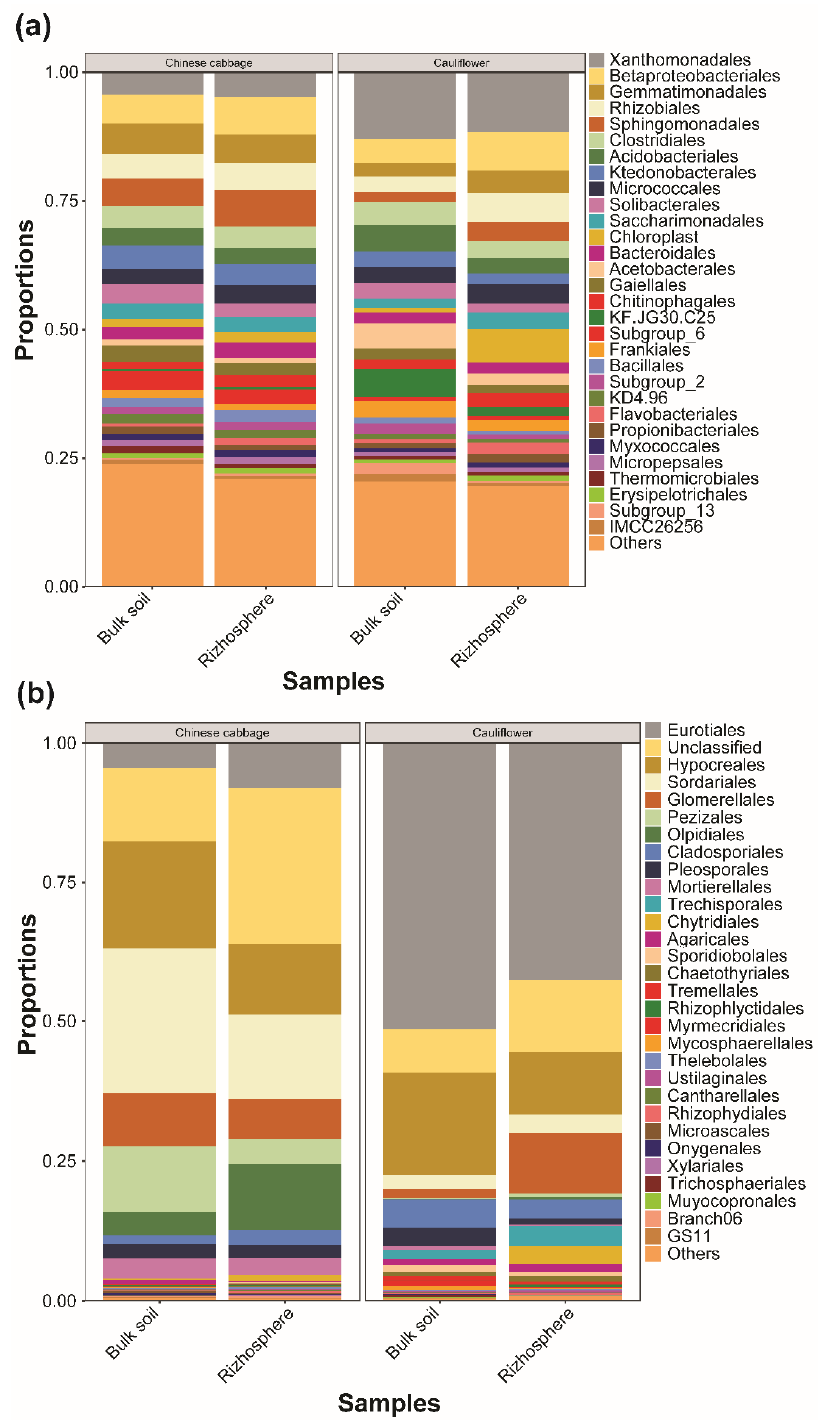
Figure 2. Relative abundance (%) of different bacterial and fungal communities in bulk and rhizo- spheric soils collected from Chinese cabbage and flower cabbage fields. ( a ) Relative abundance of bacteria at order level and ( b ) relative abundance of fungi at order